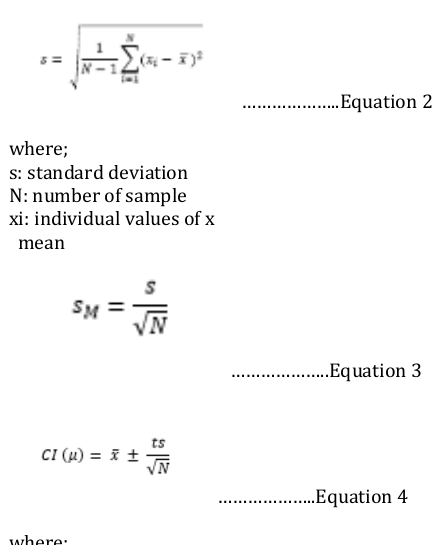
experiment was done to satisfy this analysis. The analysis includes standard deviation (SD), standard error (SE) and confidence interval (CI) at 95% by using equation (2), (3), and (4)